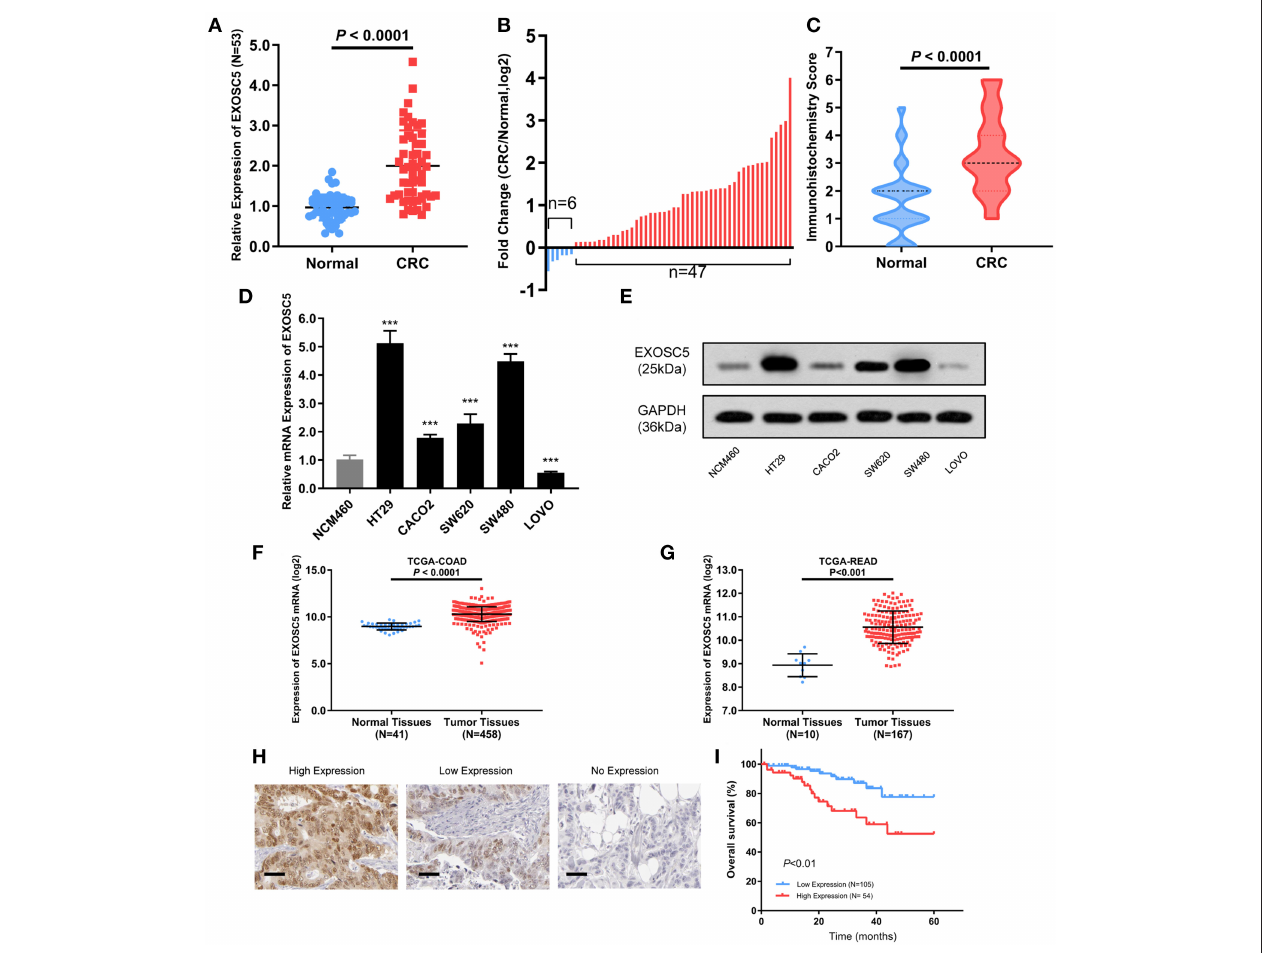
FIGURE 1 | EXOSC5 was overexpressed in CRC tissues and cells, and correlated with overall survival. (A,B) EXOSC5 mRNA levels in 53 pairs of tumor samples and matched normal tissues were determined by qRT-PCR. (C) EXOSC5 protein expression in CRC and normal tissues was measure by IHC staining. (D,E) mRNA and Protein levels of EXOSC5 in human colon cell line and five CRC cell lines measured by qRT-PCR and Western blot, respectively. (F,G) EXOSC5 expression was increased in tumor tissues compared with normal colorectal tissues in TCGA-COAD and TCGA-READ datasets. (H) Representative IHC staining for EXOSC5 in CRC tissues (scale bar: 50 µ m; magnification: 200X). (I) High EXOSC5 expression correlated with worse overall survival in CRC patients.